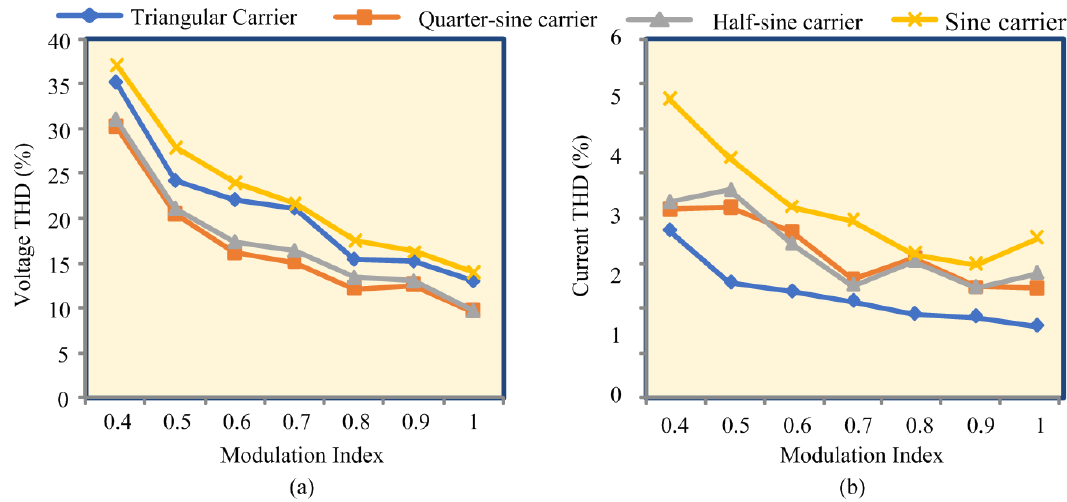
Figure 8. Comparison of ( a ) Voltage THD and ( b ) Current THD with PWM